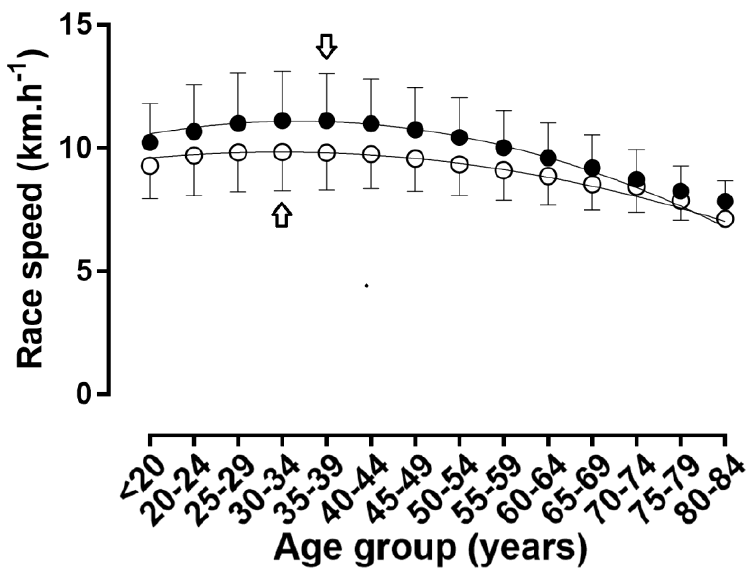
Figure 6. Running speed in 5-year age groups. Arrows denote age of peak performance. Error bars represent standard deviations; = women, ⚫ = men. (cid:35)